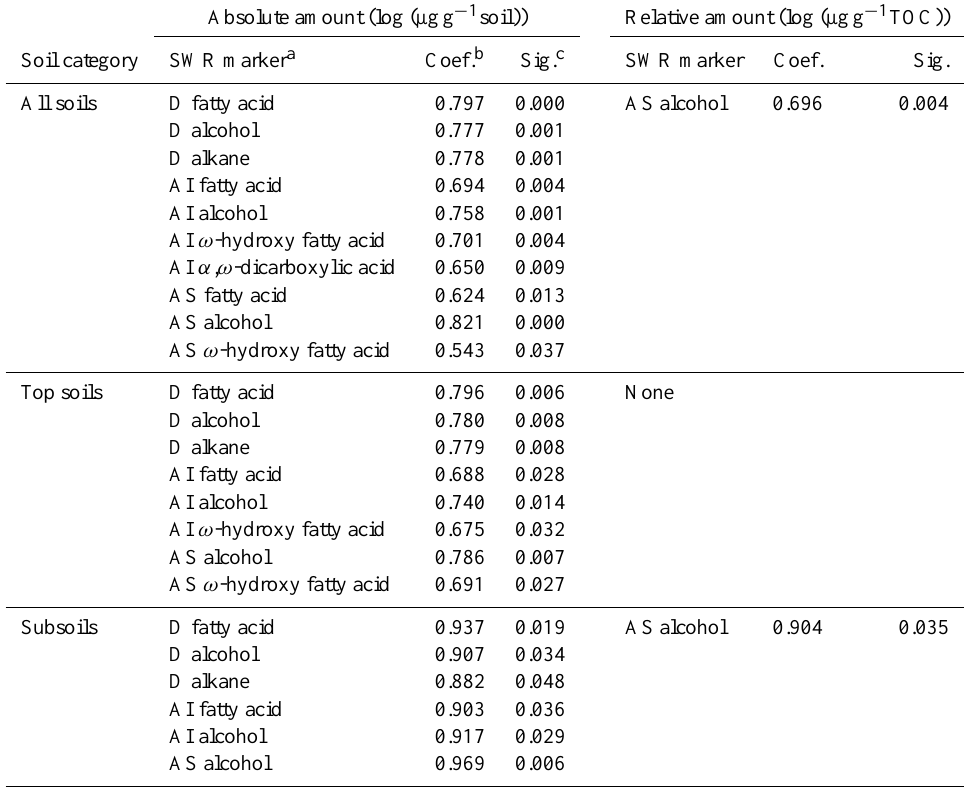
Table 3. Correlation coefficients of single SWR marker groups significantly ( < 0.05) related to SWR